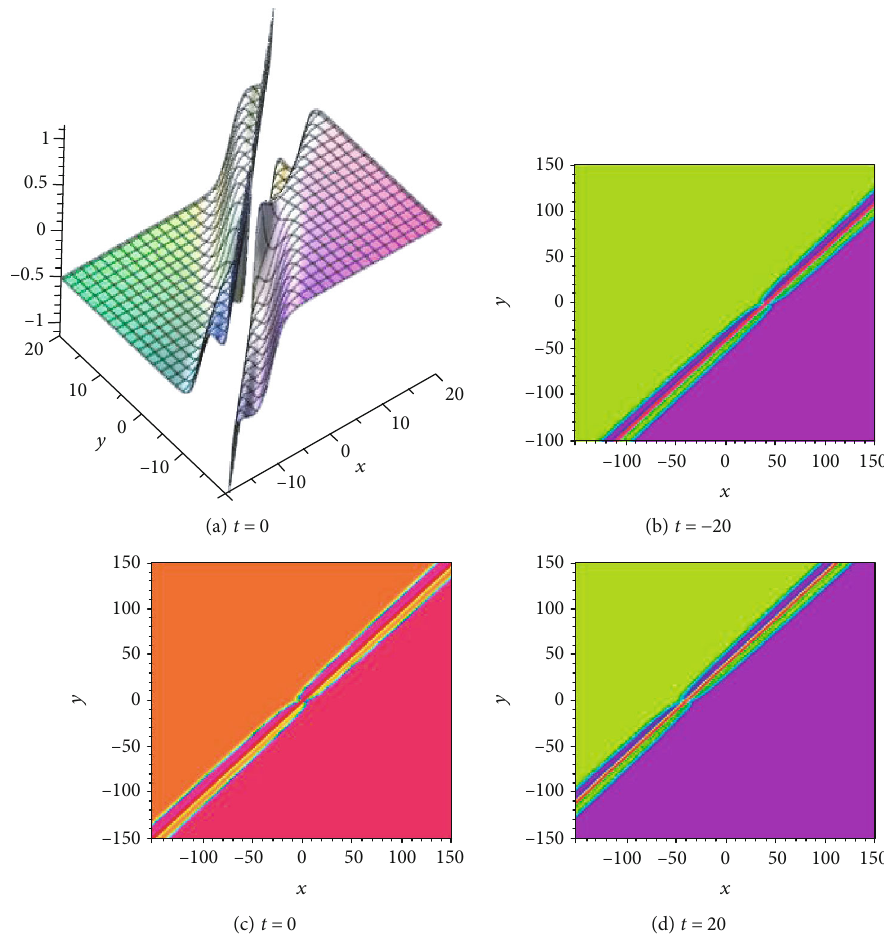
= 1 , k = 1 : 5 , k = 2 , and k = 0 . (a) 1 2 3 4